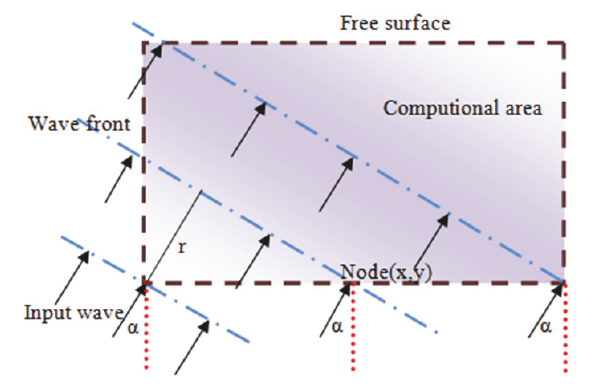
Figure 2: Free field with the obliquely incident wave.